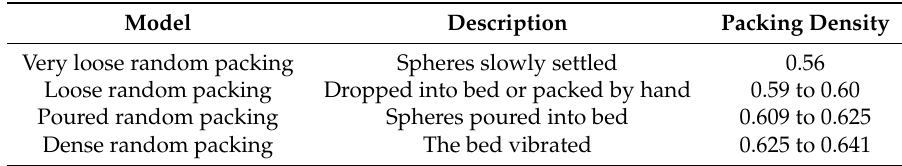
Table 1. Density states of packing models, adapted from Dullien